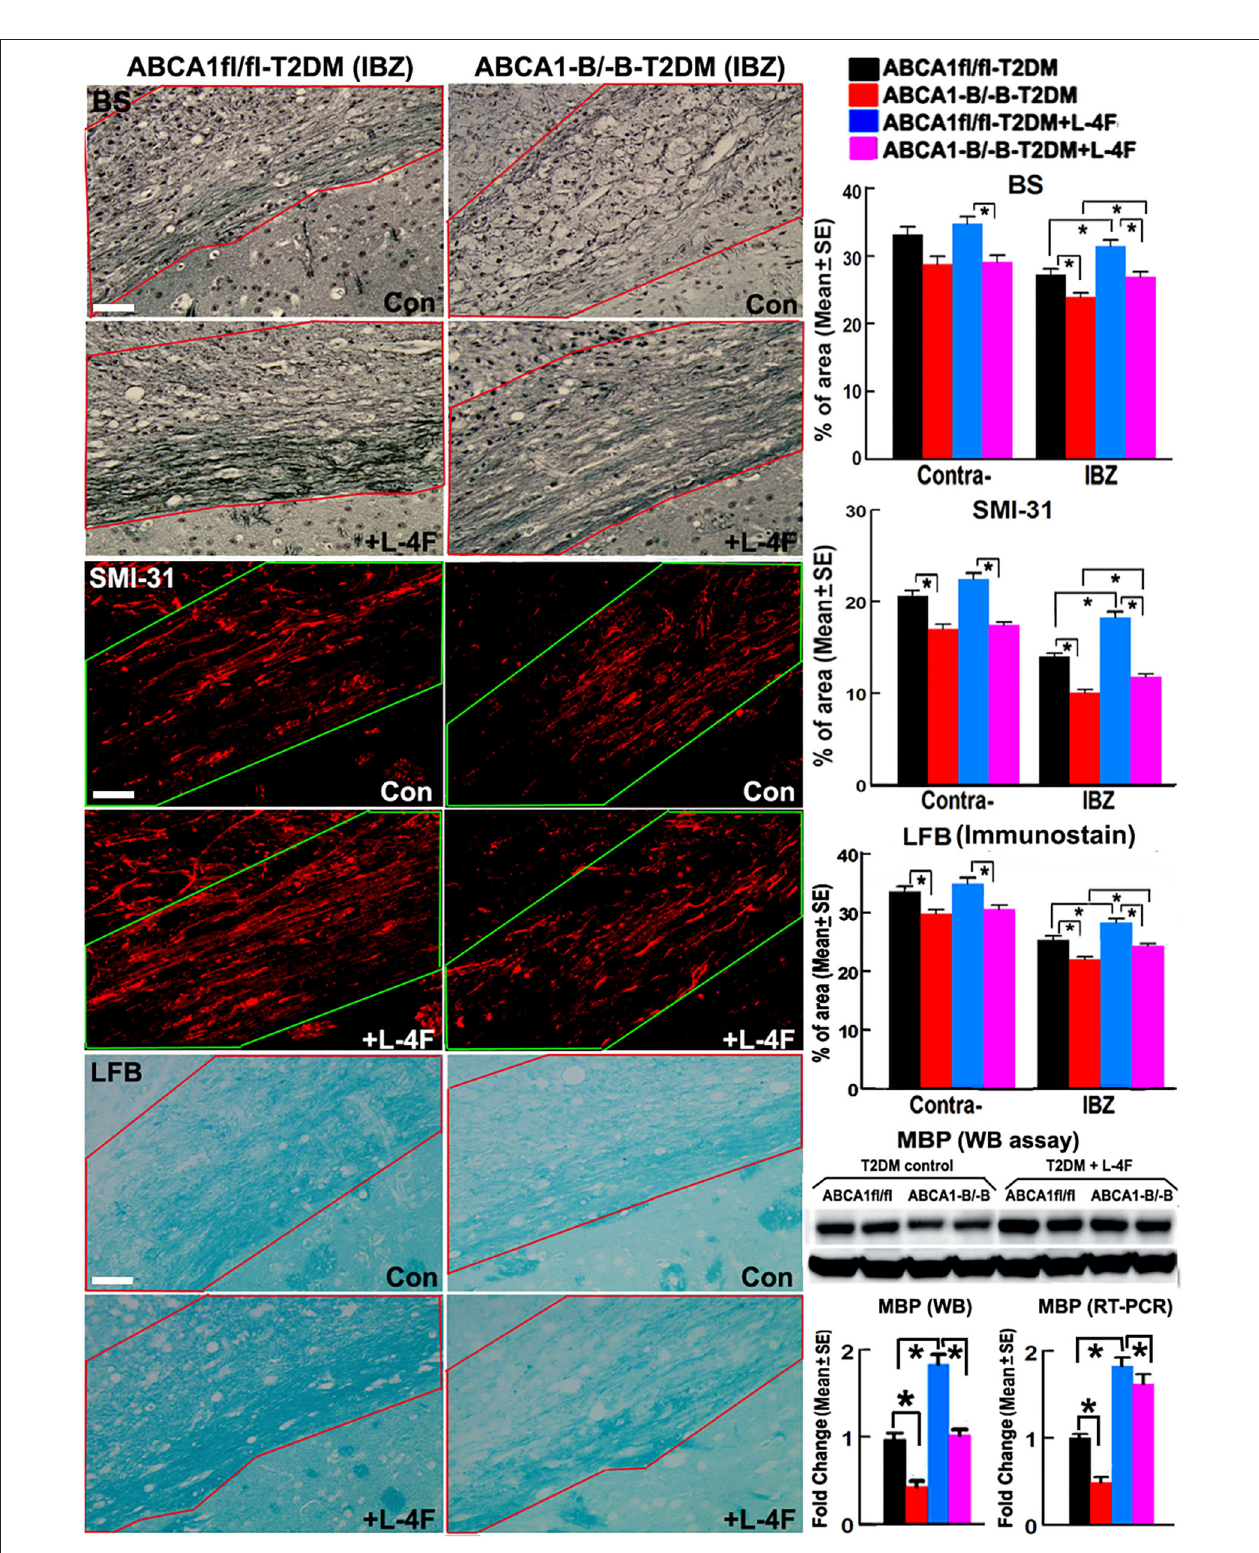
FIGURE 4 | L-4F treatment increases the densities of axon, phospho-neurofilament, and myelin in the WM-bundles in the IBZ, and MBP protein level in the ischemic brain of ABCA1 fl / fl and ABCA1 − B / − B T2DM mice at 21 days after stroke. Scale bar = 50 µ m. * p < 0.05, n = 9/group in immunostaining measurement; n = 6/group in WB and RT-PCR